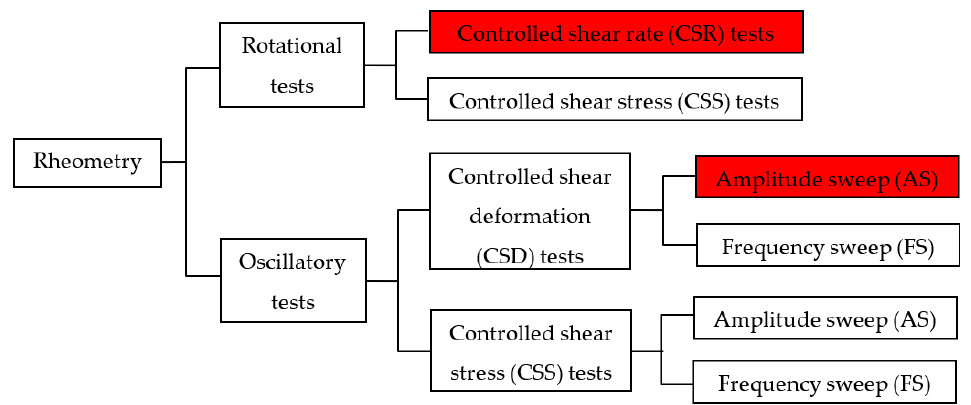
Figure 3. Rheometry methods (Colored areas indicate tests conducted in this